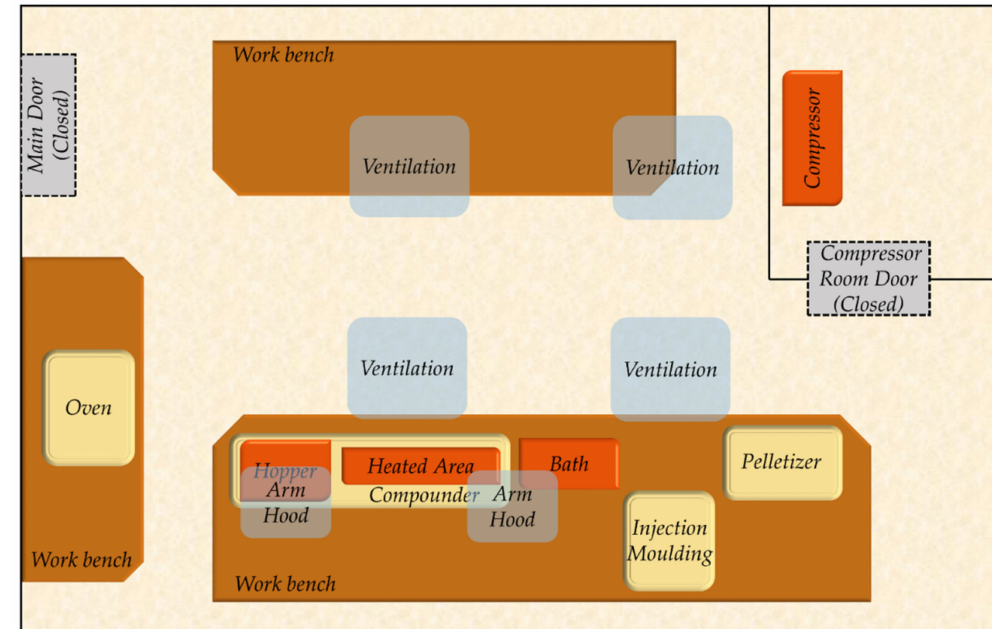
Figure 2. Top-down illustration of the manufacturing pilot